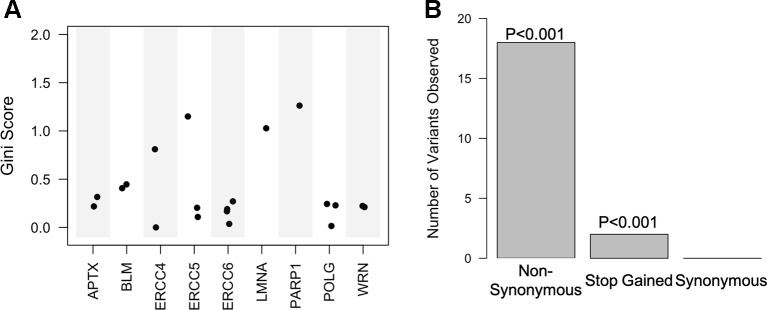
Random forest high Combined Annotation-Dependent Depletion exon predictive variants are within 9 of the 20 genes and mostly non-synonymous. (A) Scatter plot of the Gini score for each of the predictive variants based on corresponding gene. (B) Bar plot of the variant consequence type within the predictors with corresponding empirical p-values.